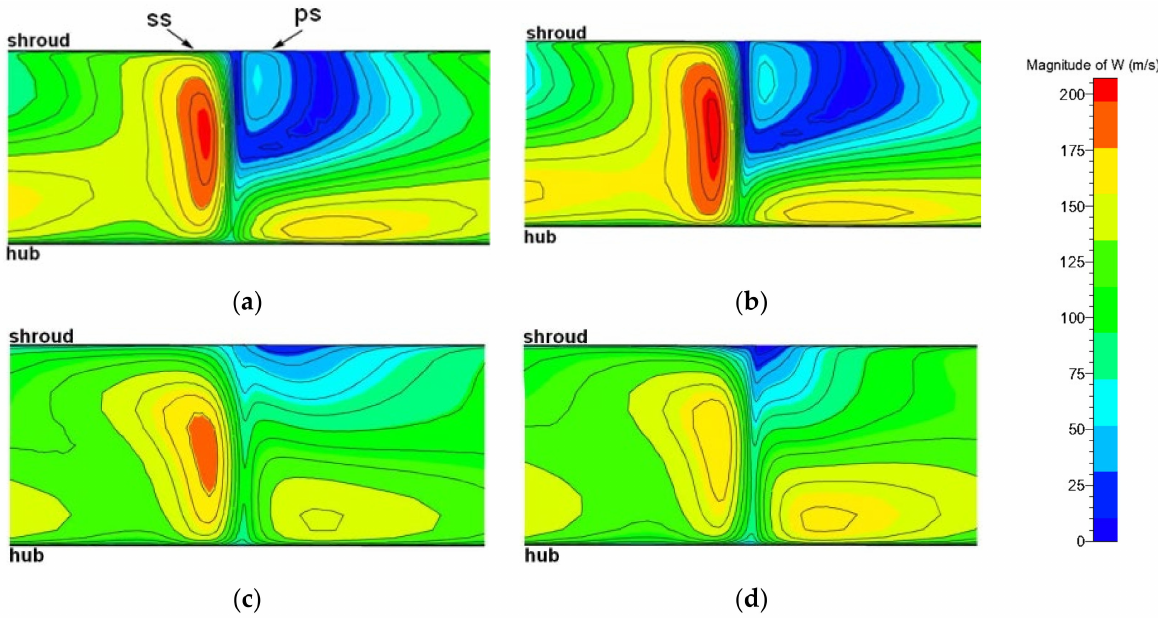
Figure 18. Relative velocity distribution at cross section near the outlet of front row blade in different cases. ( a ) 0 ◦ model; ( b ) 3 ◦ model; ( c ) 10 ◦ model; and ( d ) 18 ◦ model.